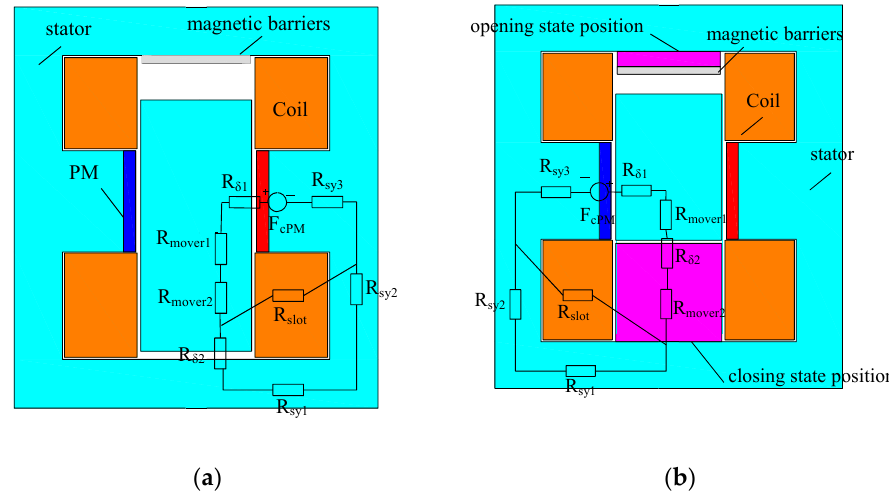
Figure 3. The main magnetic circuit. ( a ) The ASBPMA [19]. ( b ). The ABSMPMA.